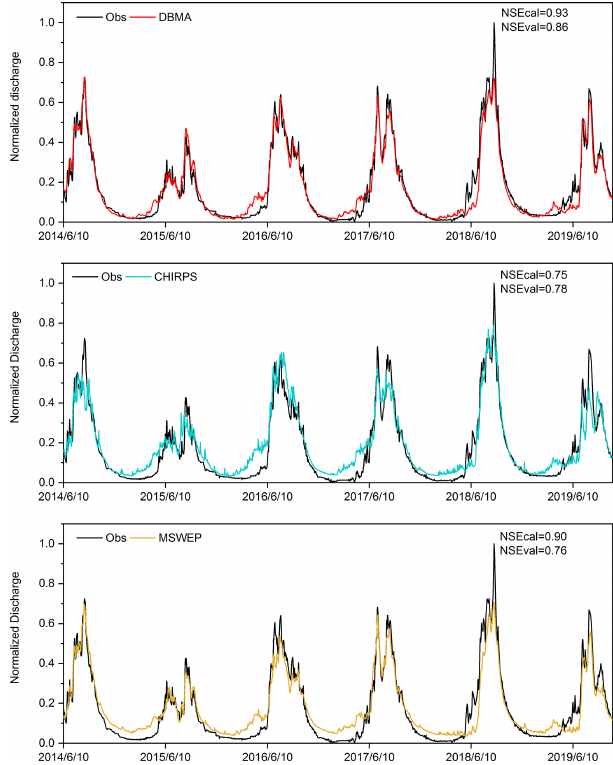
Figure 8. Simulated daily runoff at Nuxia station forced by DBMA, CHIRPS and